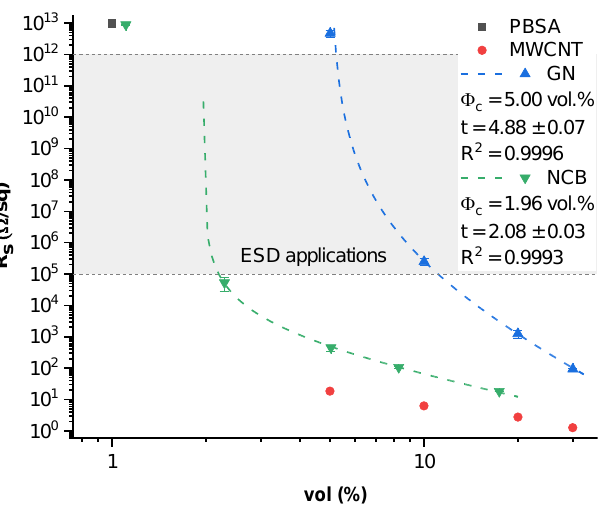
Figure 3. Surface resistivity of PBSA/carbon nanoparticle composites.